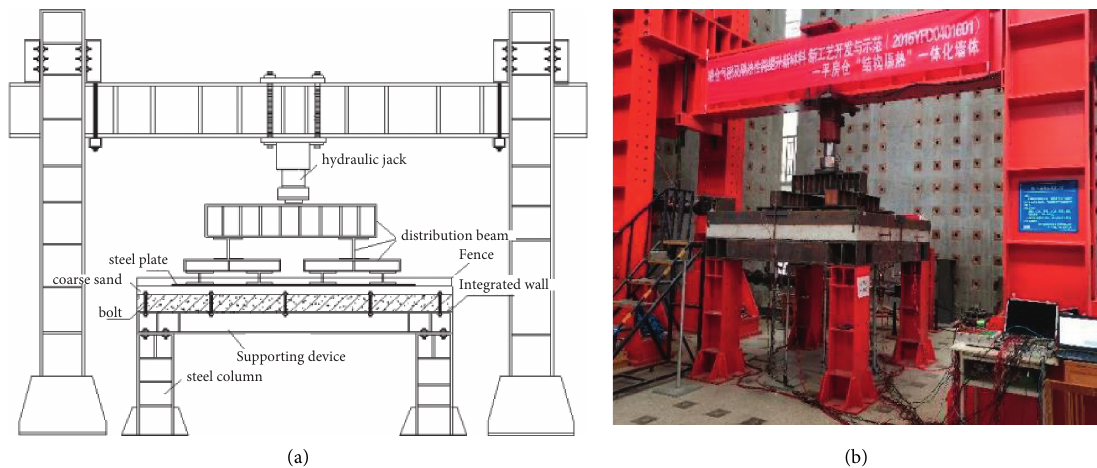
Figure 2: Test loading device. (a) Schematic diagram of the loading device. (b) Physical map of the loading